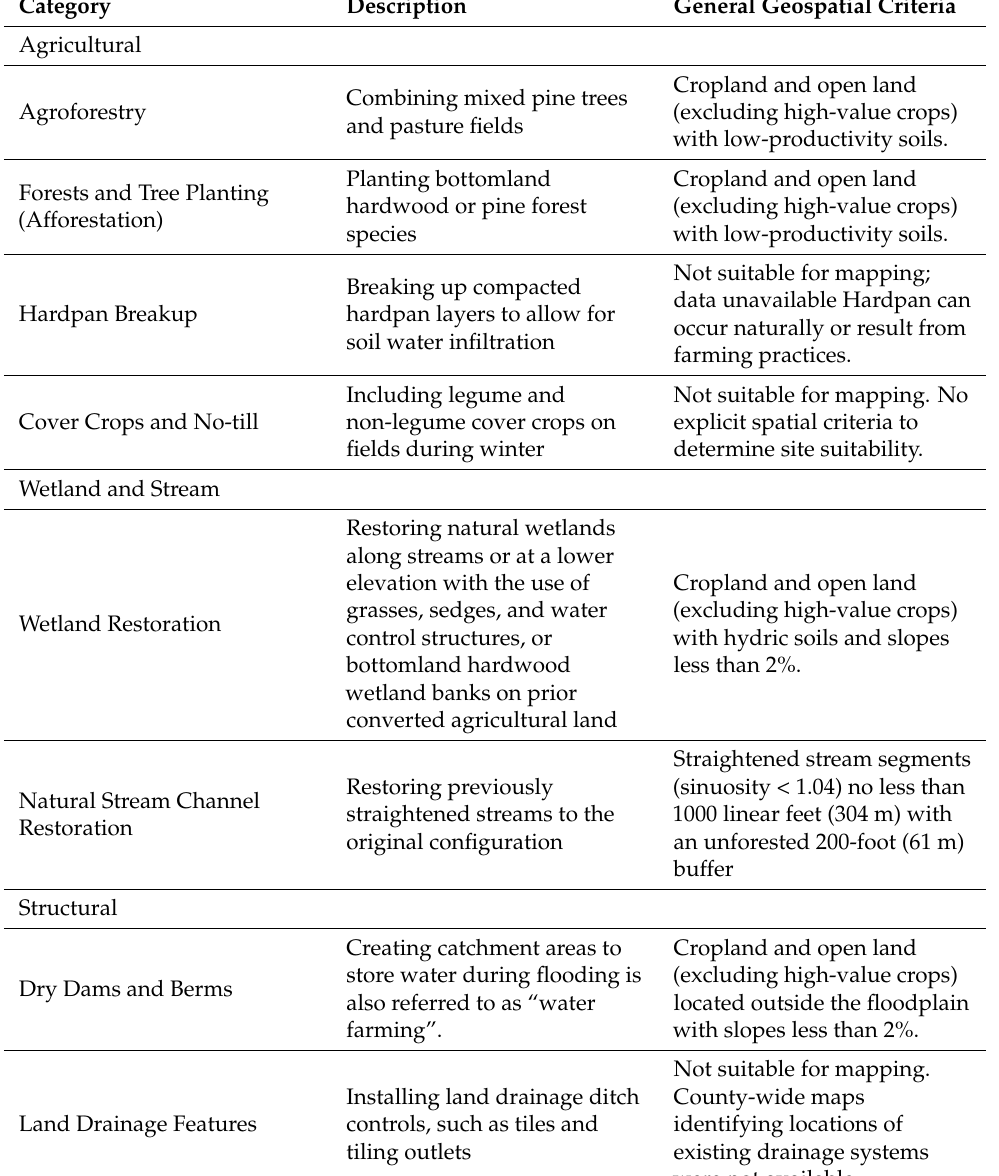
Table 1. Preferred FloodWise Flood Mitigation Practices for Rural, Eastern North Carolina, and General Geospatial Criteria for Locating Potential Opportunity Areas (Adapted from